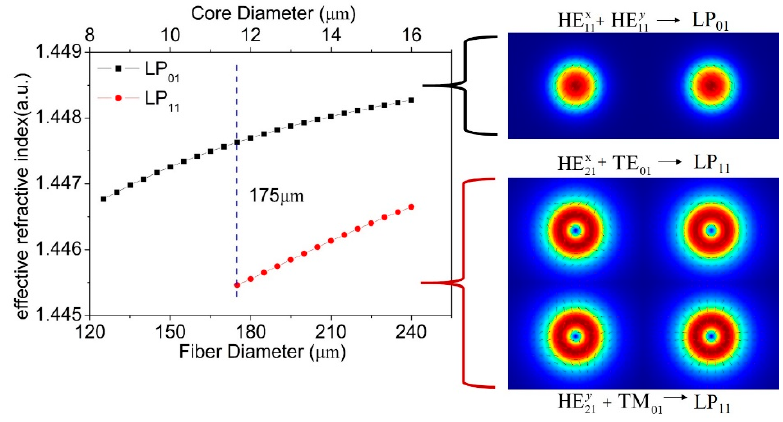
Figure 1. The relation between the transmission mode and diameter of the fiber the insets are mode fields of vector modes in two-mode fiber and the relationship of vector modes and LP modes.